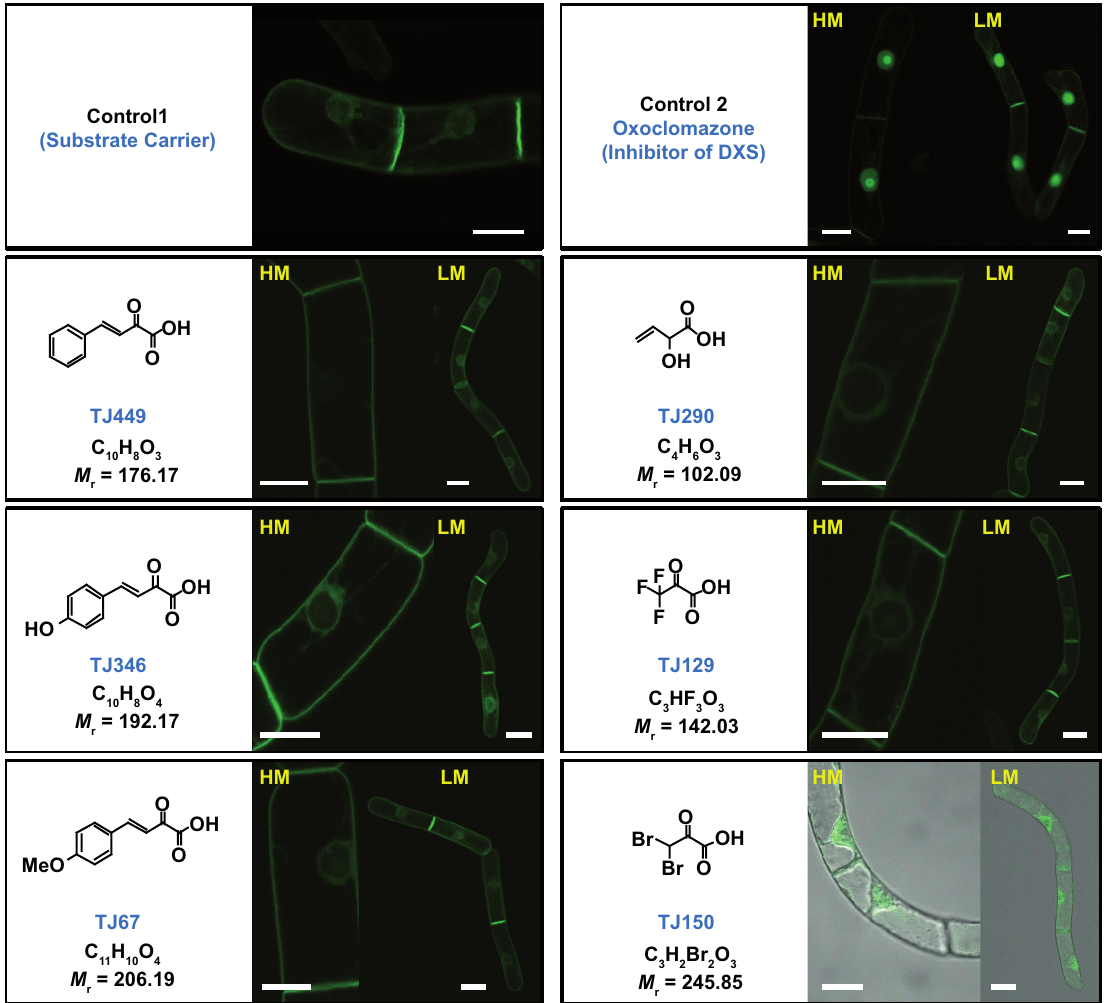
Figure 4. Confocal microscopy images showing the subcellular localization of the H -GFP-DB-CVIL fusion protein, after treatment with 6 different analogs of pyruvate based on known inhibitors of pyruvate decarboxylase and pyruvate dehydrogenase. The molecules (at a final concentration of 100µM) were dissolved and tested under standard conditions (3 h treatment, followed by induction with 10µM dexamethasone and examination by fluorescence microscopy 15 h later). Cells were also treated by 50µM oxoclomazone as described previously (positive control). None of the six tested compounds showed a mislocalization of the GFP fluorescence to the nucleus. The compound TJ150, however, appeared to be cytotoxic at the given concentration as cells displayed typical signs of cell death (over 90% of treated cells did not show any fluorescence).